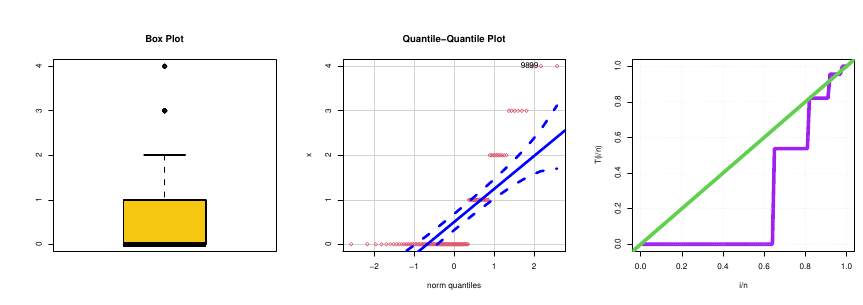
Figure 5 – Box plot, Q-Q plot and TTT plot for the carious teeth data.